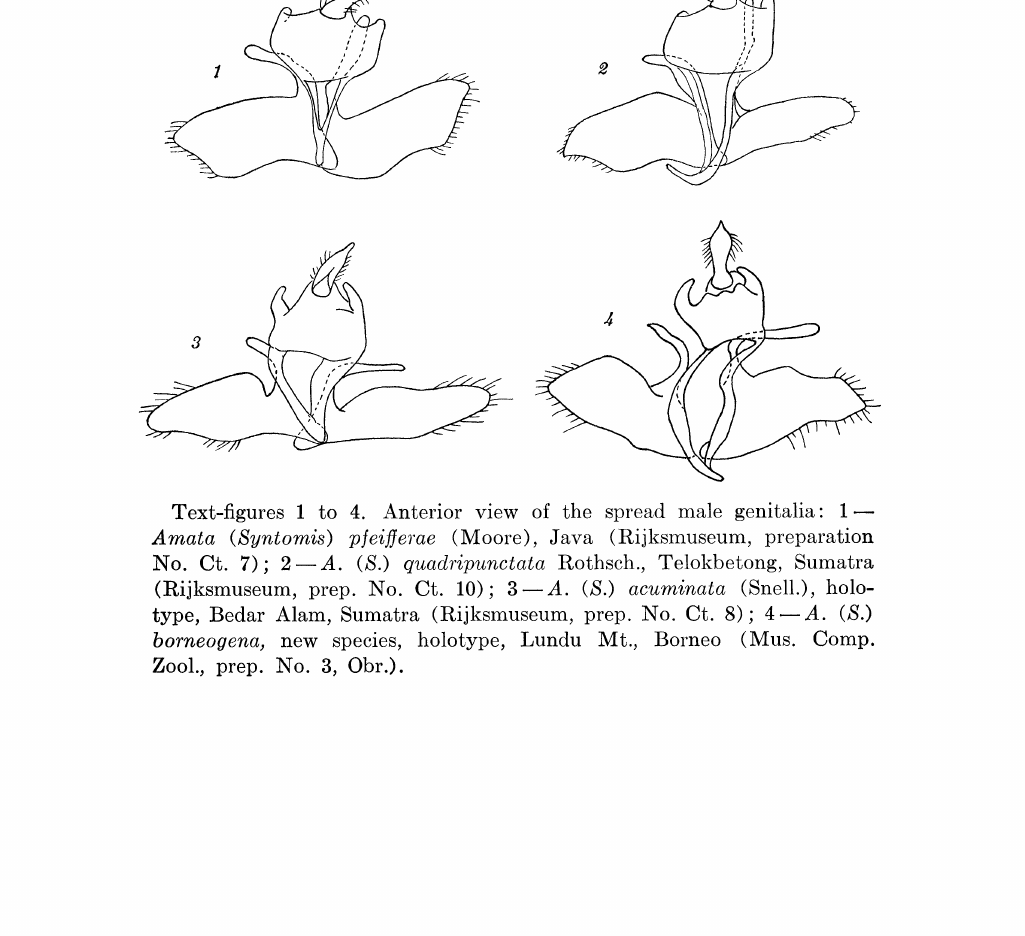
Head Thorax (damaged!) with orange scales at the middle and po.sterior edge; pectus with two orange patches on each side. Abdomen black; first